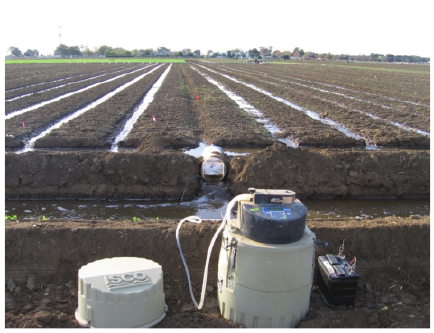
Figure 1: Runoff sample collection using ISCO autosampler from the short